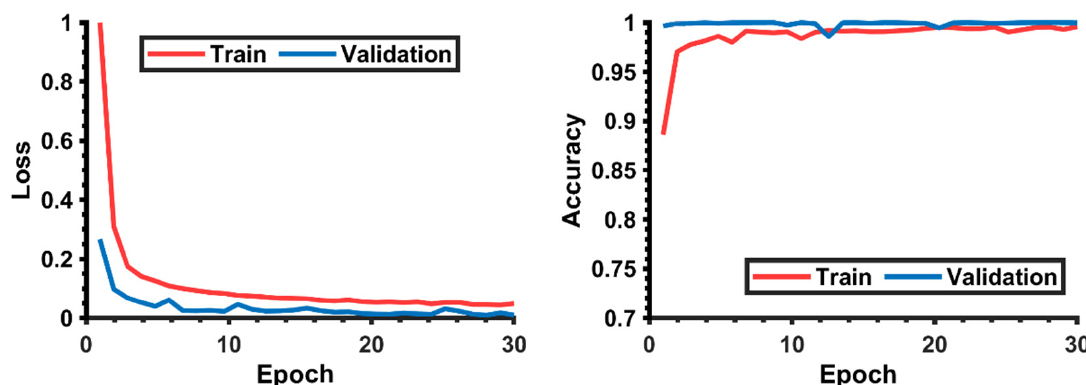
Figure 10. Training and validation curve of accuracy and loss.